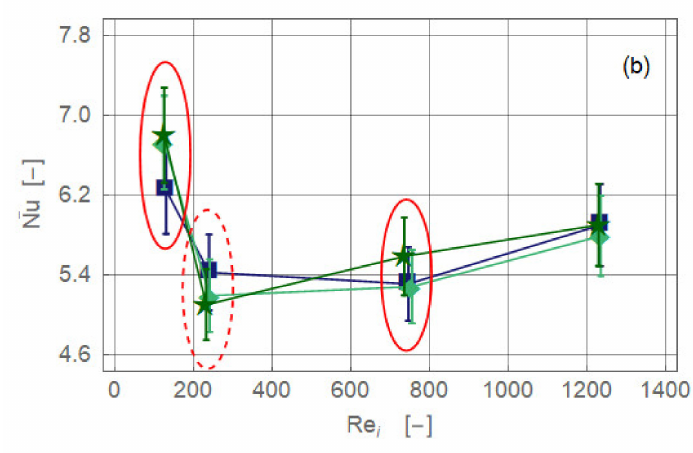
Figure 8. Comparison of averaged Nusselt number for different inlet Reynolds numbers with r cl = 34 mm. Symbols indicate ferronanofluid without magnet (dark blue (cid:4) , ( a , b )), magnet below (orange (cid:78) , ( a )), magnet above (dark orange (cid:72) , ( a )), two magnets attracting (light green (cid:7) , ( b )), and two magnets repulsing (dark green (cid:70) , ( b )). Increases are marked with full and decreases with bro- ken